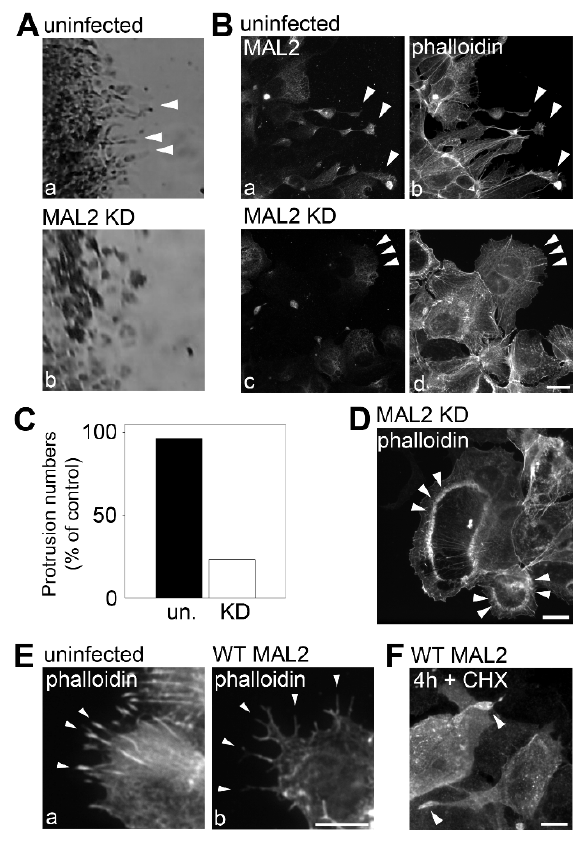
Figure 4. MAL2 expression in Hep3B cells correlates with actin-based protrusion formation. ( A ) The boxed areas from Figure 3B were enlarged. Arrowheads indicate long protrusions present in uninfected migrating cells that were lost in cells knocked down for MAL2 expression (MAL2 KD). ( B ) Uninfected cells and cells knocked down for MAL2 at the migrating edge were double-labeled for MAL2 (with anti-FLAG antibodies) and actin (with phalloidin). Arrowheads in panels a and b indicate long, MAL2- and actin-positive protrusions present in uninfected migrating cells whereas arrowheads in c and d point out the smooth surfaces in migrating cells knocked down for MAL2 expression. ( C ) Cells from Part B were scored for the presence of protrusions. Values represent the number of MAL2 KD cells with protrusions relative to uninfected cells. ( D ) Cells knocked down for MAL2 expression were immunolabeled for actin with phalloidin. Arrowheads mark dorsal ruffle-like structures. ( E ) Uninfected and MAL2 overexpressing WIF-B cells present at the edge of a scratch were labeled for actin with phalloidin. Arrowheads mark long protrusions present at the cell surface. ( F ) Hep3B cells overexpressing MAL2 were treated for 4 h with 50 µ g / mL cycloheximide and immunolabeled for MAL2 with anti-FLAG antibodies. Arrowheads point to MAL2 labeling present at the ends of the long protrusions. Bar = 10 µ